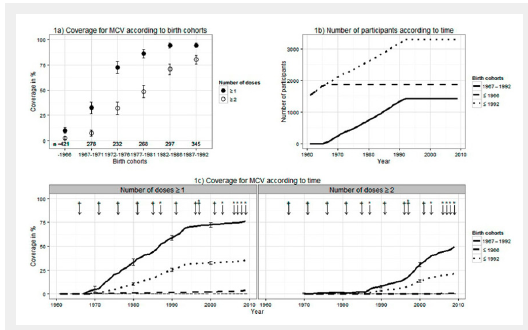
(a) Measles-containing vaccine (MCV) coverage for various birth cohorts at one and two doses; n represents the size of the birth cohort. (b) Number of participants according to year and birth cohort ≤1966, 1967‒1992 and ≤1992. Starting in 1993 the curve is flat since no new participants were considered. (c) MCV coverage over time for birth cohorts ≤1966, 1967–1992 and ≤1992. Arrows labelled with (+) indicate when changes to the measles / measles- mumps-rubella recommendations were made in the Swiss Immunization Schedule and arrows labelled with (*) show the occurrences of large measles outbreaks in Switzerland that were published. The bars on the coverage data represent Wald confidence